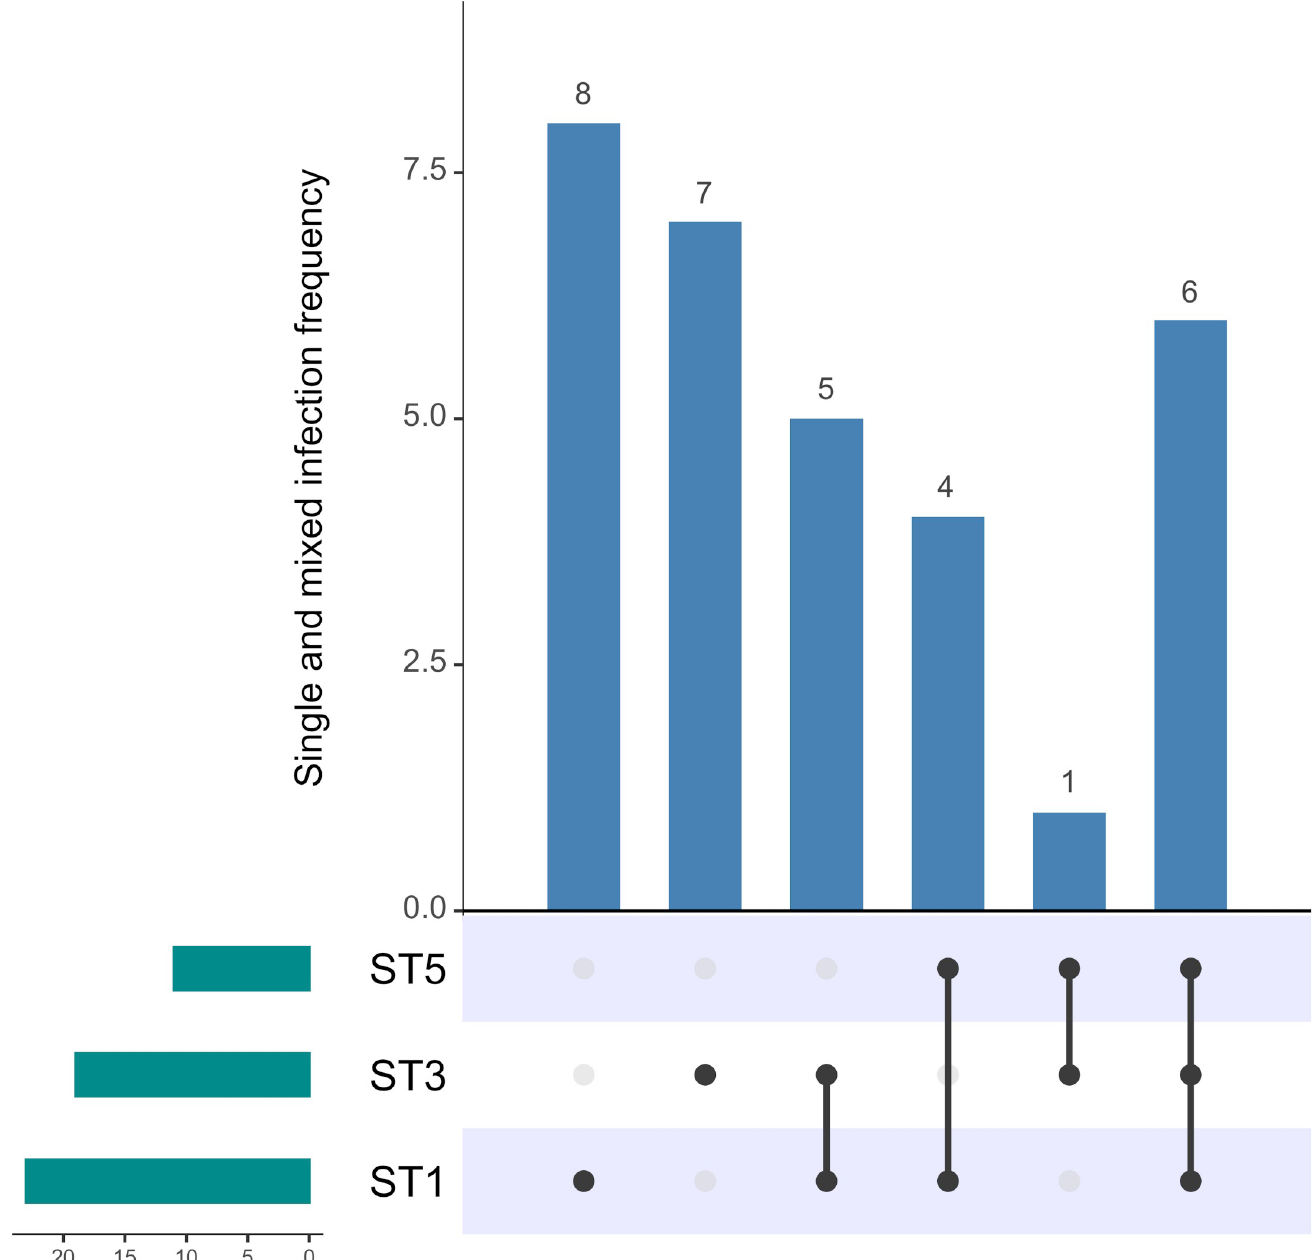
Fig 1. Frequency of Blastocystis subtypes in the 31 fecal samples (B+/C+). The absolute frequency of each ST is displayed in the lateral bar plot (green). The panel with the dots represents the single or mixed infections, which frequency is displayed in the main bar plot (blue). https://doi.org/10.1371/journal.pone.0248185.g001 The sequencing of the 16S-rRNA V4 gene fragment of the 115 fecal samples showed that the most abundant phylum was Firmicutes and represented approximately 30% of reads for the three groups. The most abundant phyla followed by Firmicutes were Bacteroidetes and Proteobacteria, being Bacteroidetes the second most abundant in the B+/C+ and B-/C- groups,